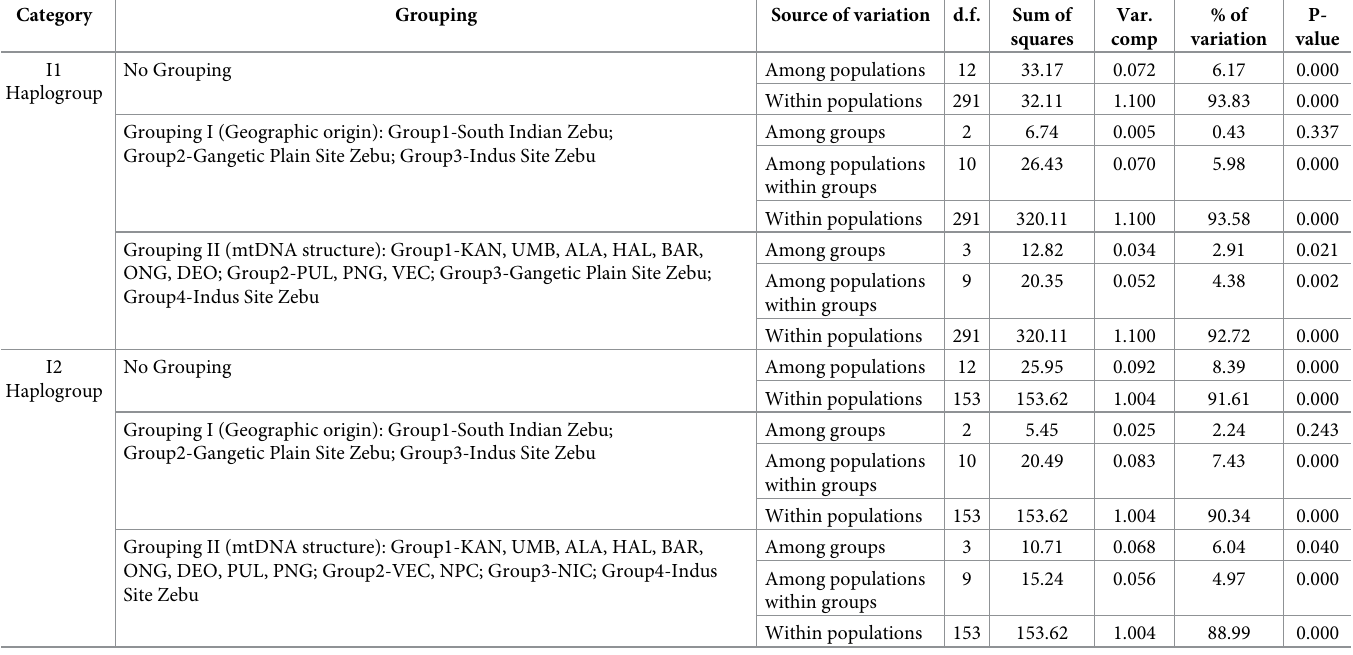
Table 6. Analysis of molecular variance among mtDNA haplotypes of zebu cattle of South India, Indus valley site and Gangetic plains. Category